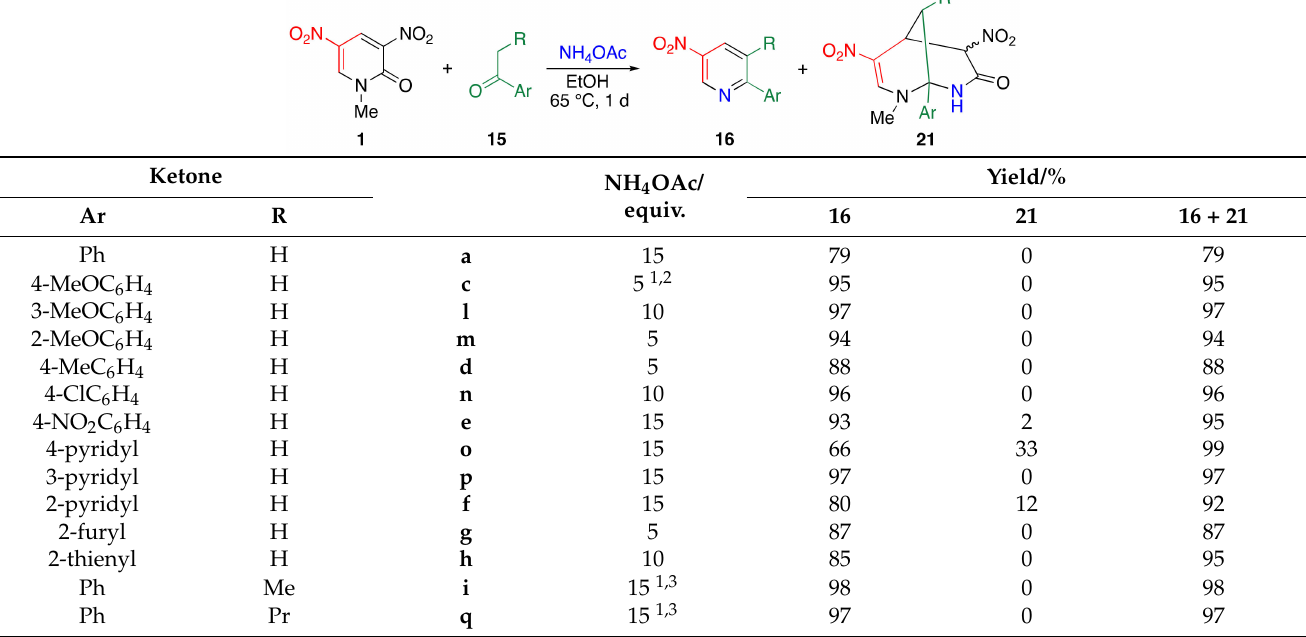
Table 4. TCRT with other aromatic ketones 15 .